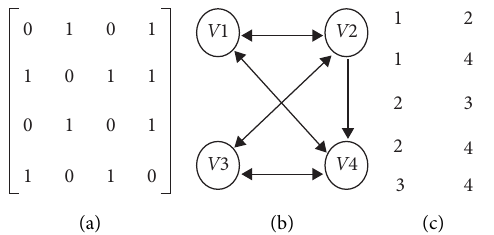
Figure 1: The nodes relationship of Complex Network for (a) adjacent matrix; (b) connected relationship; (c) adjacent